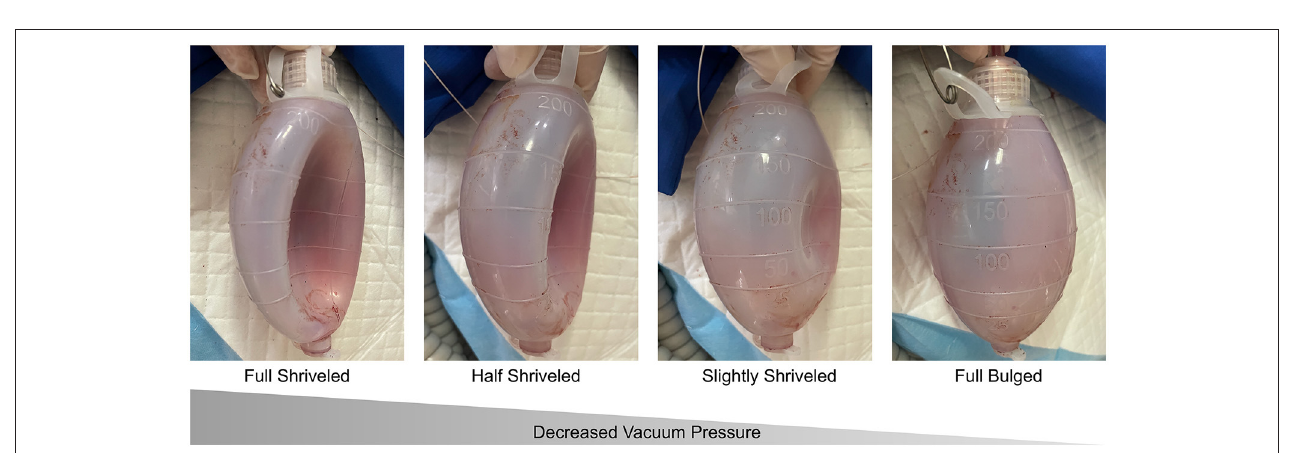
FIGURE 8 | Different levels of shriveled drainage